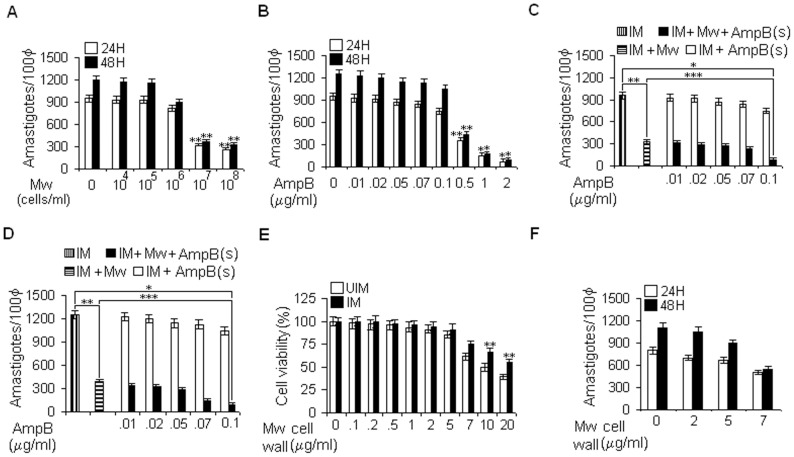

Mw significantly reduces the intracellular parasitic load (A–D).Peritoneal macrophages, isolated from BALB/c mice, were cultured in 8-chambered glass cover slides with complete RPMI 1640 media followed by infection with L. donovani promastigotes (macrophage: parasitic ratio of 1∶10) for 4 h. Macrophages were treated with different doses of Mw (A) or AmpB (B) for 20 h and 44 h. Intracellular parasites were counted per 100 macrophages after Giemsa staining. Similarly, in a separate experiment, macrophages were infected with L. donovani promastigotes followed by treatment with Mw (107 cells/ml) along with different doses of AmpB for 20 h and 44 h as indicated in the (C) & (D). Intracellular parasites were counted per 100 macrophages after Giemsa staining. Determination of noncytotoxic dose of
Mw
 cell wall and it effect on the parasitic burden in
L. donovani
-infected murine peritoneal macrophages
(E–F). Uninfected (UIM) and infected (IM) macrophages were subjected to Mw cell wall treatment at specified doses (0.1–20 µg/ml) After 48 h of incubation, cell viability assay was performed using the MTT method (E). Infected (IM) macrophages were treated with different doses of Mw cell wall (2–7 µg/ml) for 20 h and 44 h (F). Intracellular parasites were counted per 100 macrophages after Giemsa staining. The experiment was repeated 3 times, yielding similar results and data were expressed as mean ± SD. *P<0.001, **P<0.01 compared with infected macrophages and ***P<0.05 compared with Mw treated macrophages; paired two-tailed Student’s t-test.